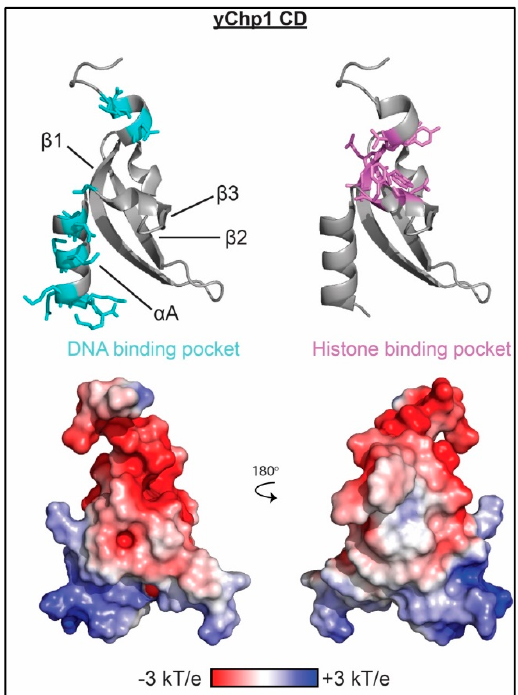
Figure 5. The molecular mechanism of CD association with nucleic acid. Residues determined to be important for binding nucleic acid as mapped by NMR spectroscopy and/or mutagenesis are shown as cyan sticks on ribbon representations of the Chp1 CD structure (PDBID 2RSN). Residues important for histone binding are shown as violet sticks. Corresponding representation of the electrostatic surface (determined using the APBS plug-in in pymol) is shown in two orientations.